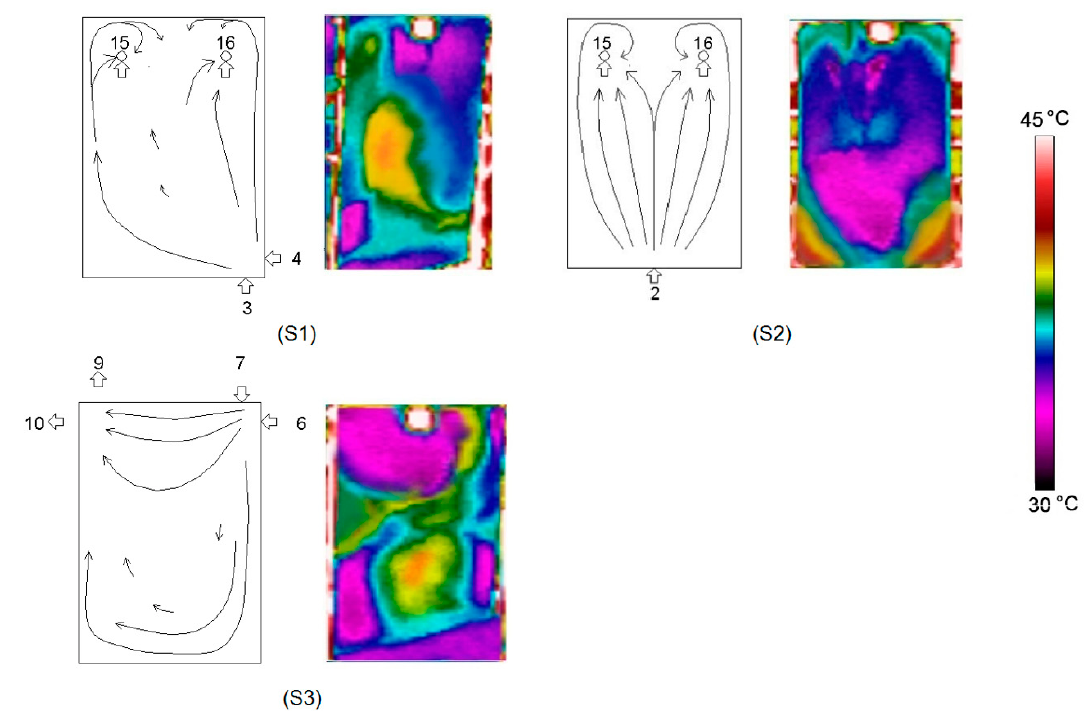
Figure A2. Diagrams of expected flow lines for group S configurations, alongside their respective thermographic images. The reader is referred to Table 2 for the description of each configuration.